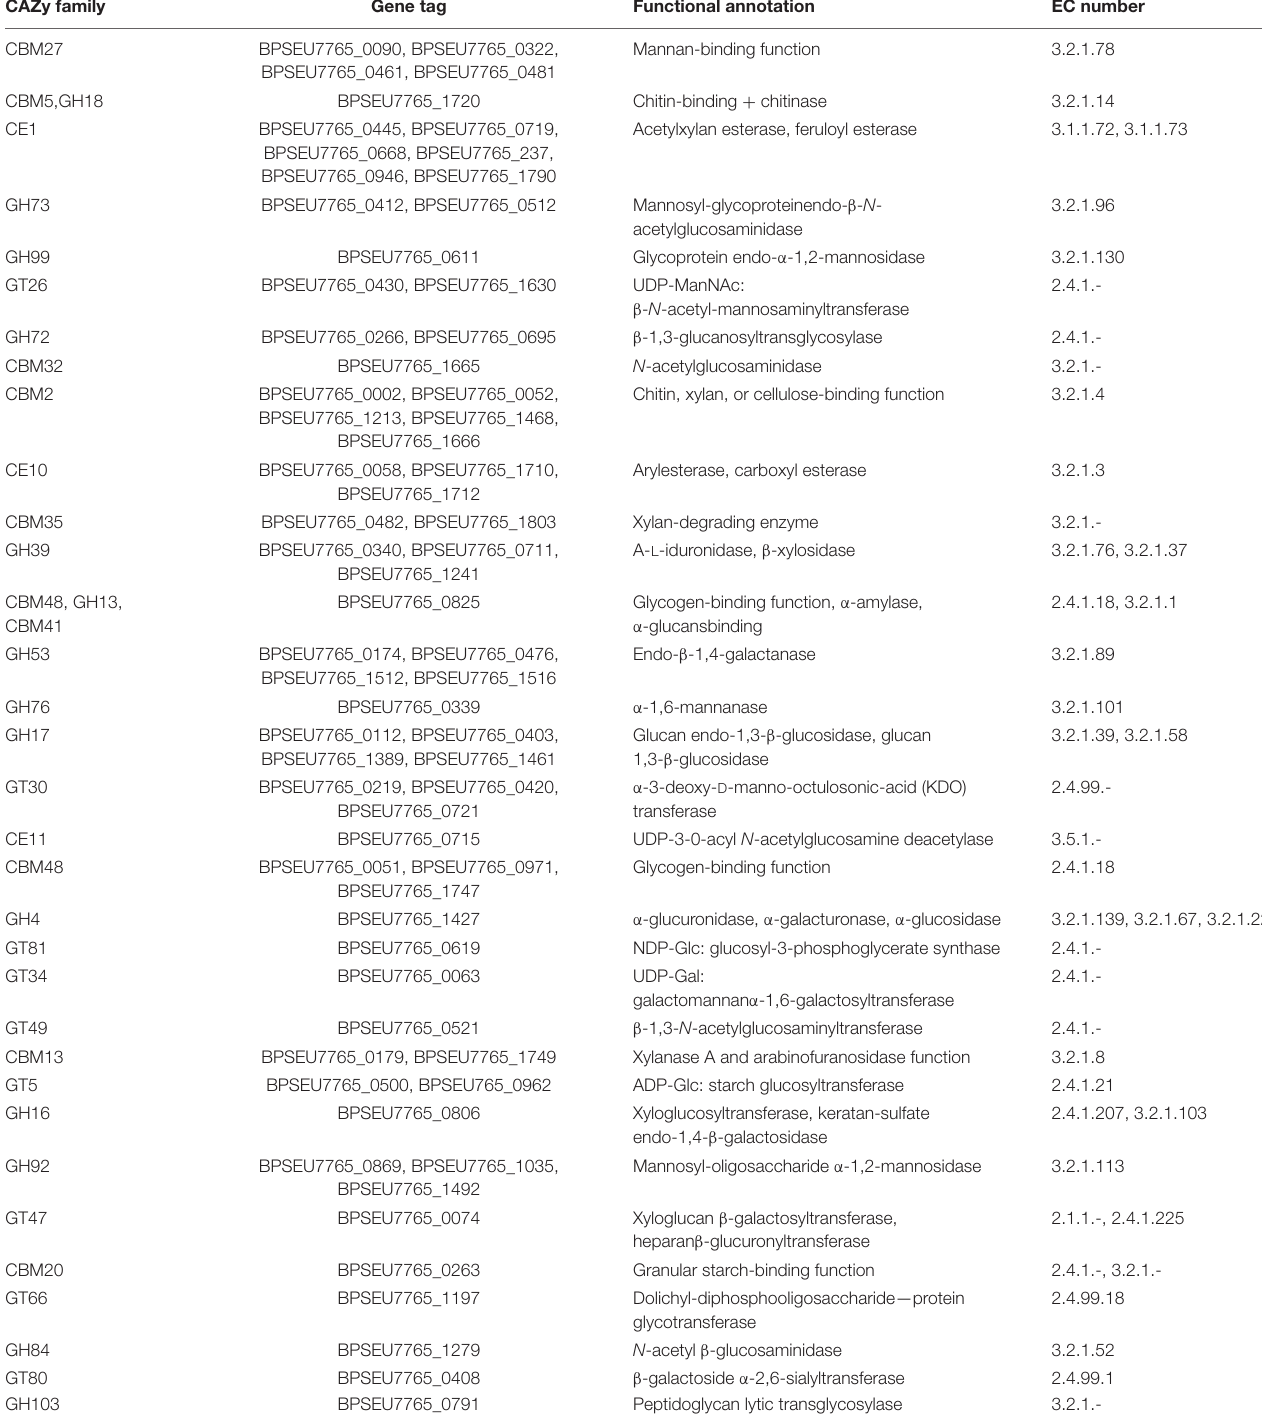
TABLE 1 | CAZy-based functional annotation of Bifidobacterium pseudocatenulatum CECT 7765 enzyme. CAZy family Gene